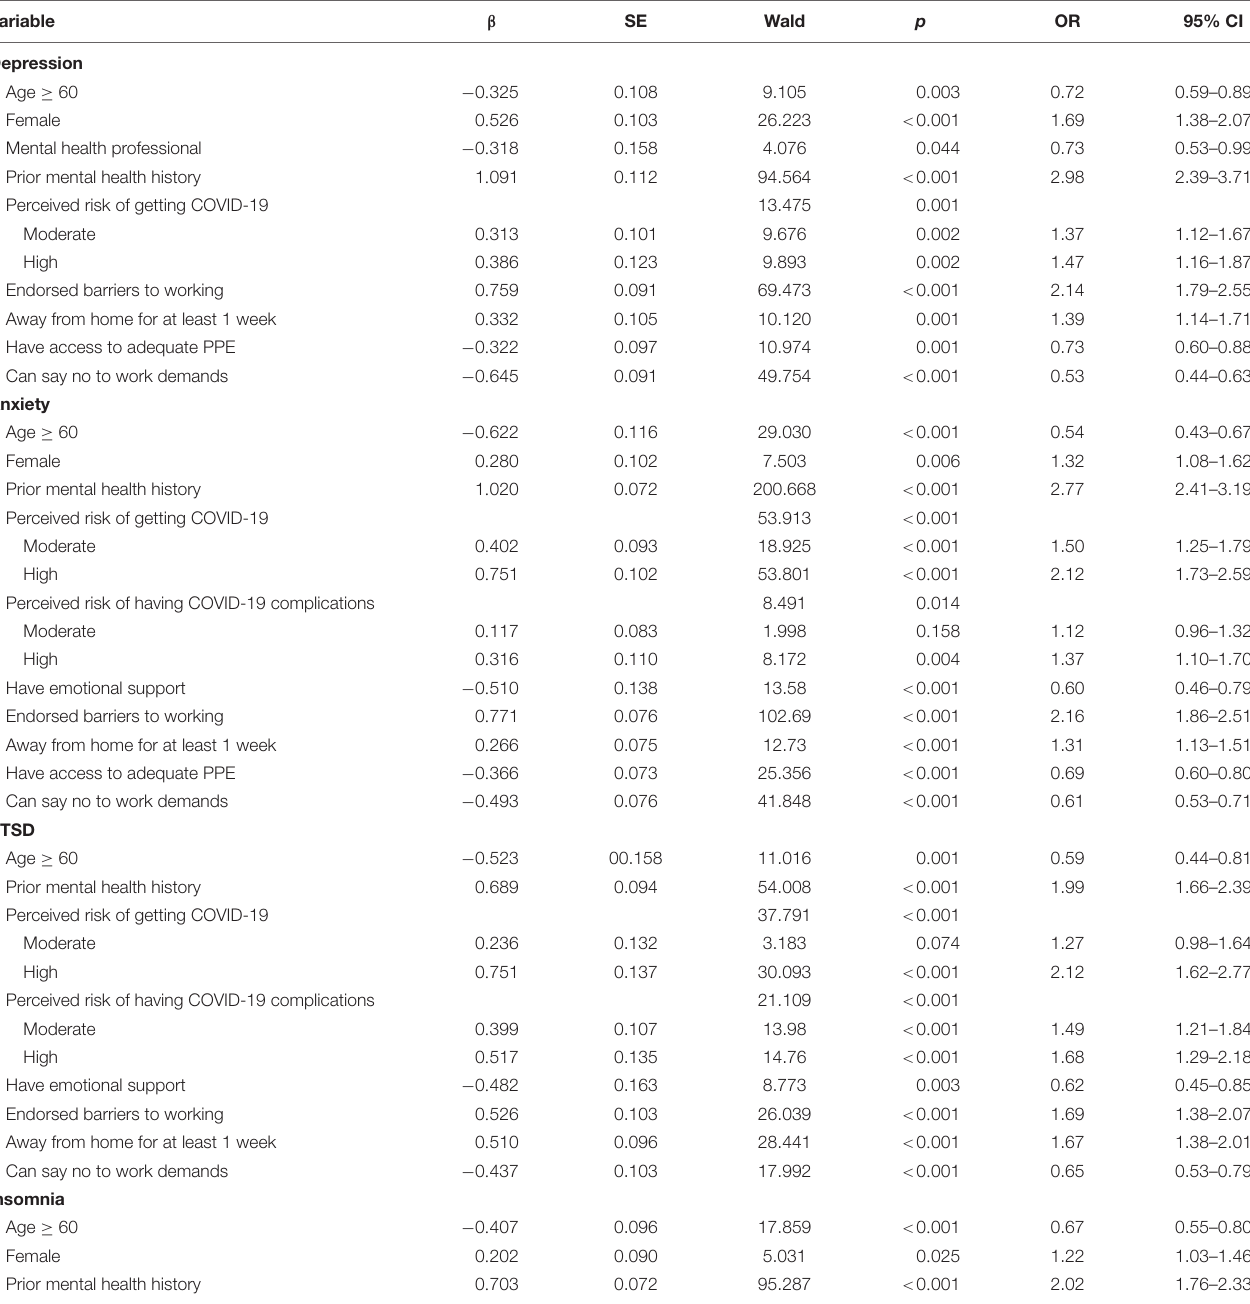
TABLE 4 | Logistic regressions for depression, anxiety, post-traumatic stress disorder (PTSD), and insomnia.